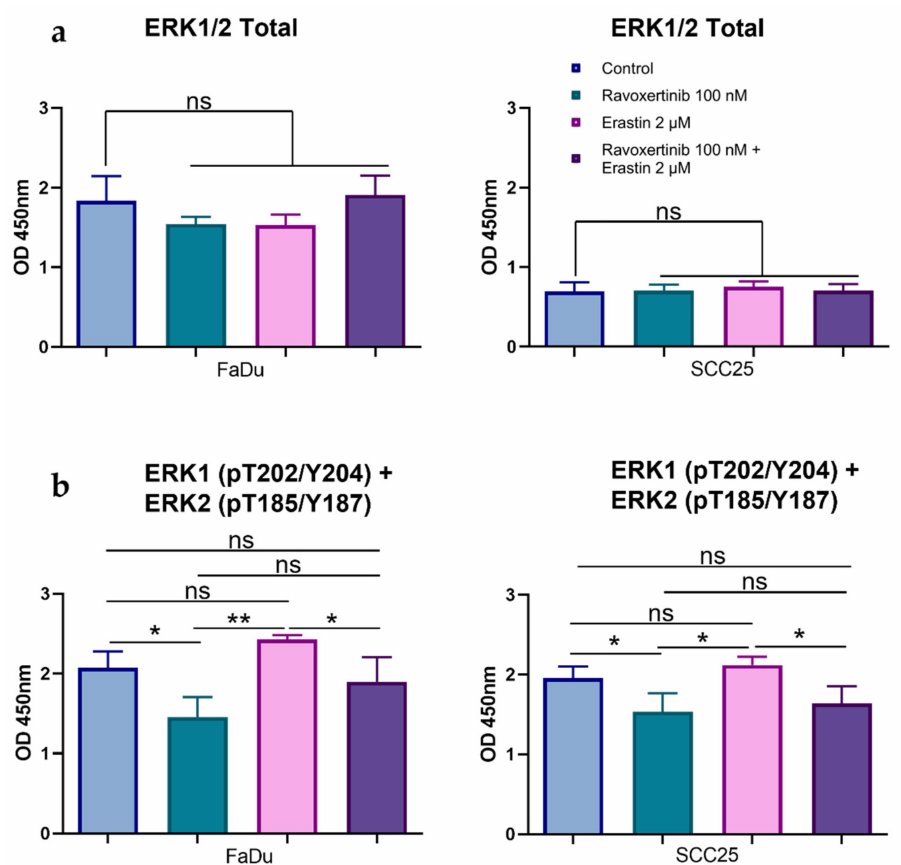
Figure 5. Effects of erastin and ravoxertinib on the expression of total and phospho-Erk1/2. Levels of the total Erk1/2 ( a ) and phospho-Erk1 (T202 + Y204) and –Erk2 (T185 + Y187) ( b ) were determined in FaDu and SCC25 cells 24 h after treatment with erastin (2 µ M), ravoxertinib (100 nM), or their combination. Data are presented as mean + SD after three independent experiments, * p < 0.05, ** p <